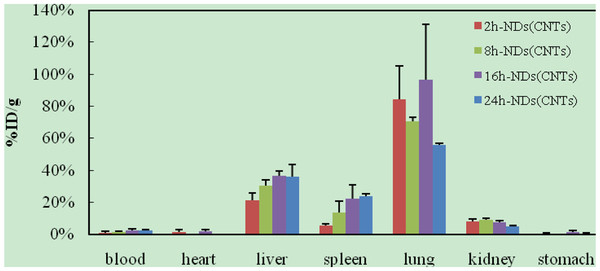
Biodistribution of NDs in mice at 2, 8, 16, and 24 h post i.v. with 99mTc-NDs + oMWCNTs.